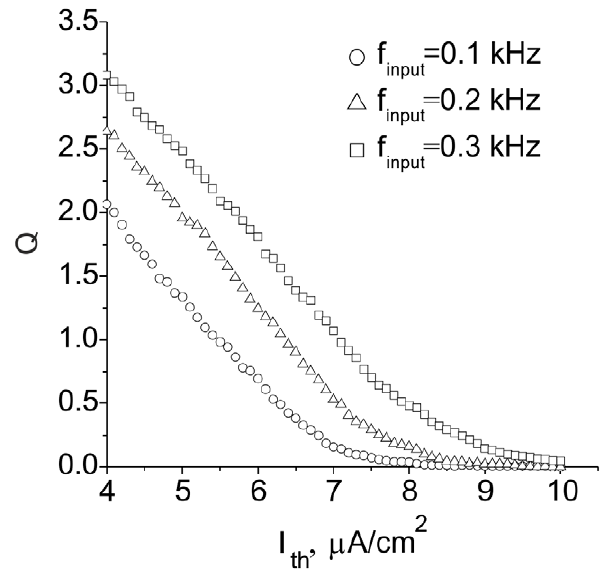
Figure 5. The dependence of average activity on threshold regulating parameter I th calculated from Eqs. (1)–(6) for different input frequencies. Parameter values: b =10, k q =0.01, a q =0.0001 msec 2 1 , and b q =0.01 msec 2 1 .